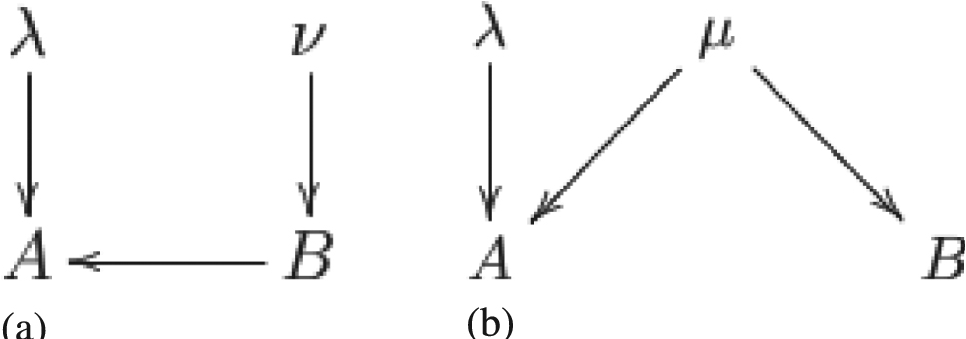
Figure 4: (a) DAG for causal model defined by u = u ⊕ u and u = u (b) DAG for causal model defined by u = u ⊕ u and u = u .